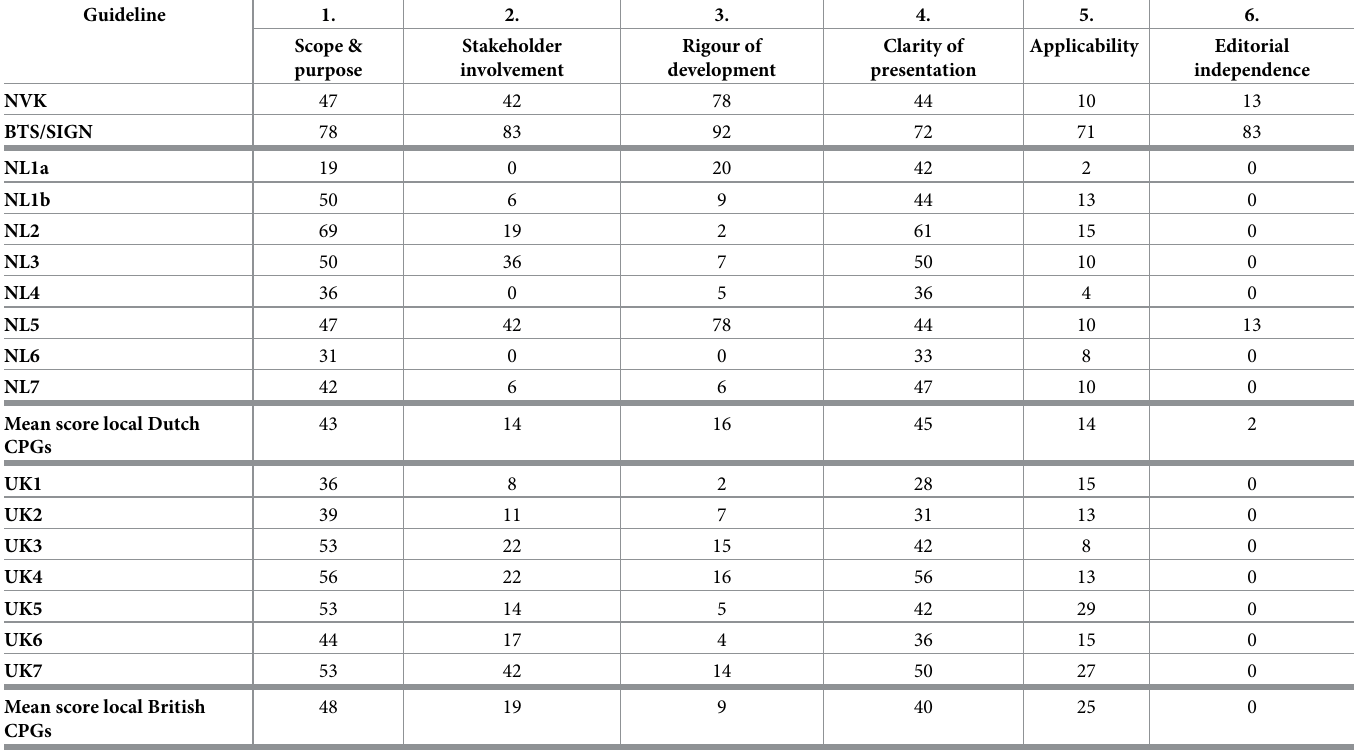
Table 3. Scaled AGREE II domain scores of sampled national and local APA guidelines from the Netherlands and the UK (%).